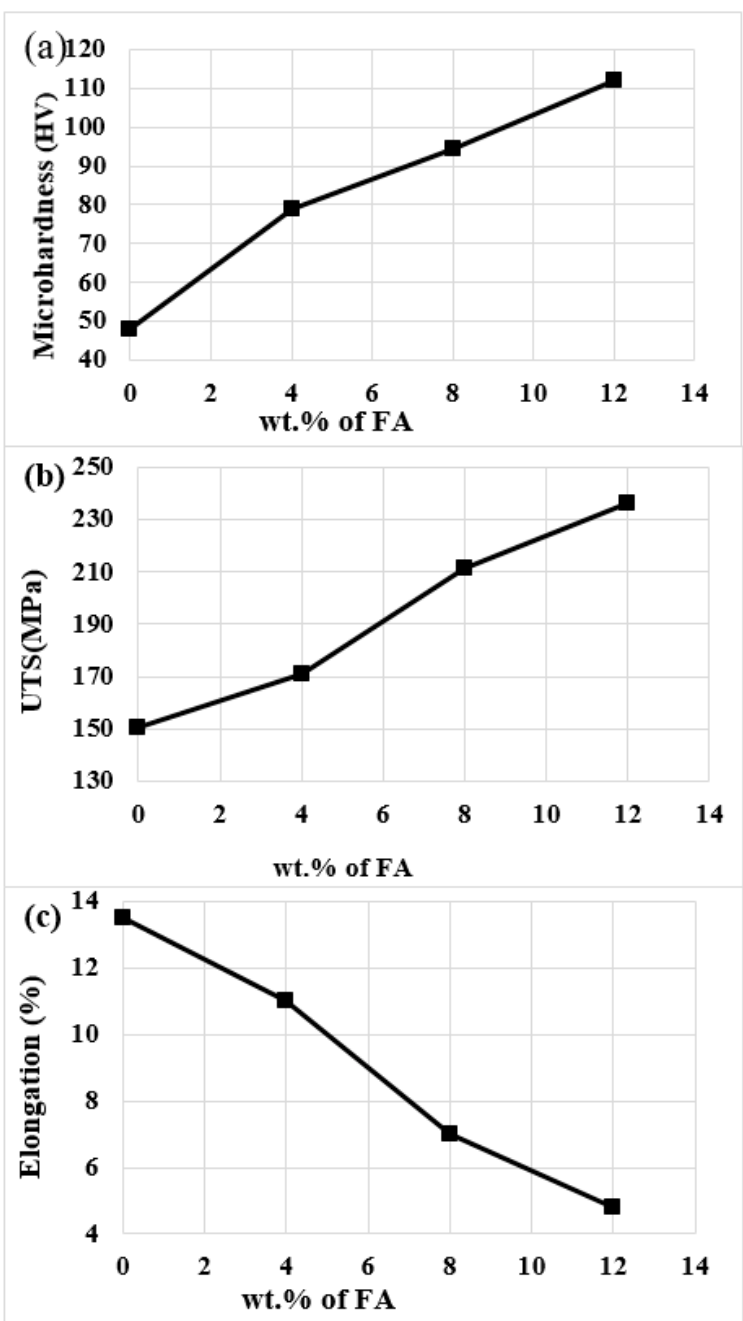
Figure 4. ( a ) Effect of FA content on microhardness ( b ) tensile strength and ( c ) elongation of AA6061-FA compocast composites [75].